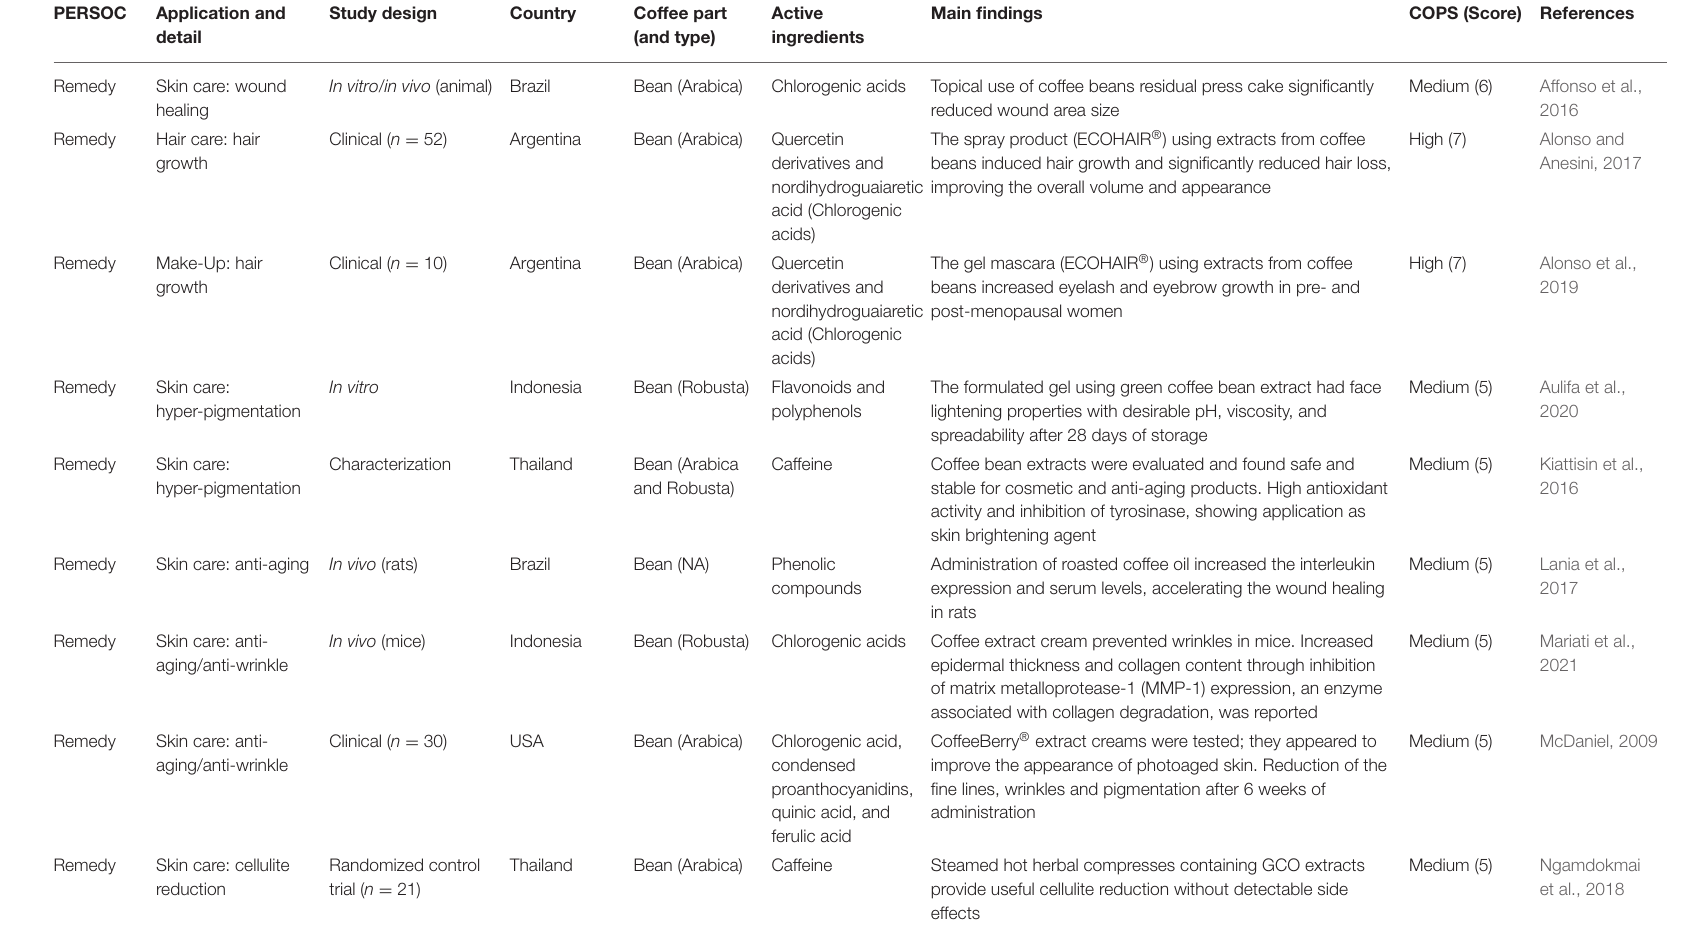
TABLE 4 | Data extraction and COPS classification of the 25 papers classified according to PERSOC where “Remedy” is perceived as the dominant aim.